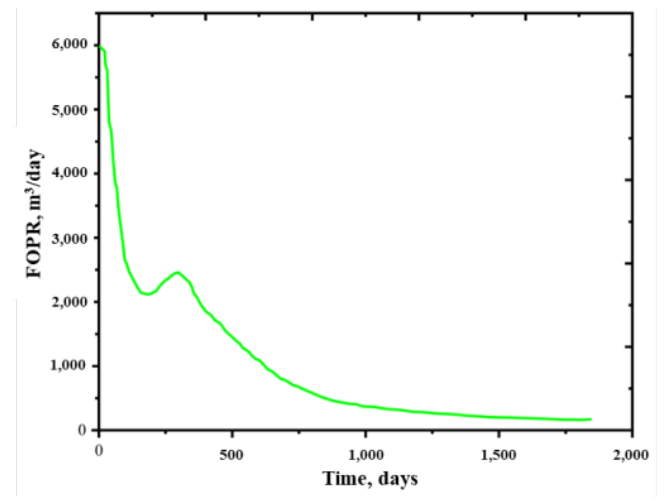
Figure 19. Field oil production rate for vertical well.